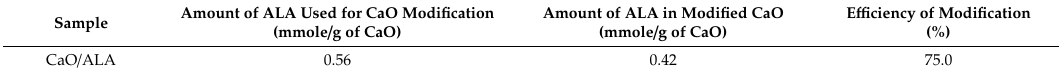
Table 5. Content of ALA in the coagent and the e ffi ciency of CaO